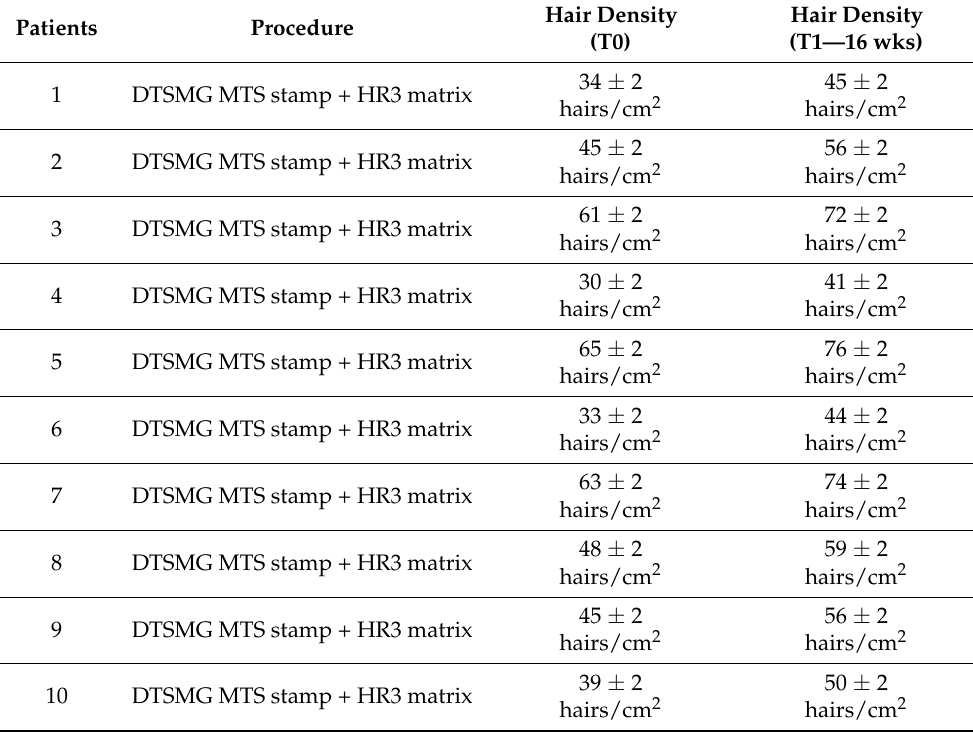
Table 2. In vivo evaluation using trichoscopy analysis in terms of hair density (HD) (hairs/cm 2 ) improvement.